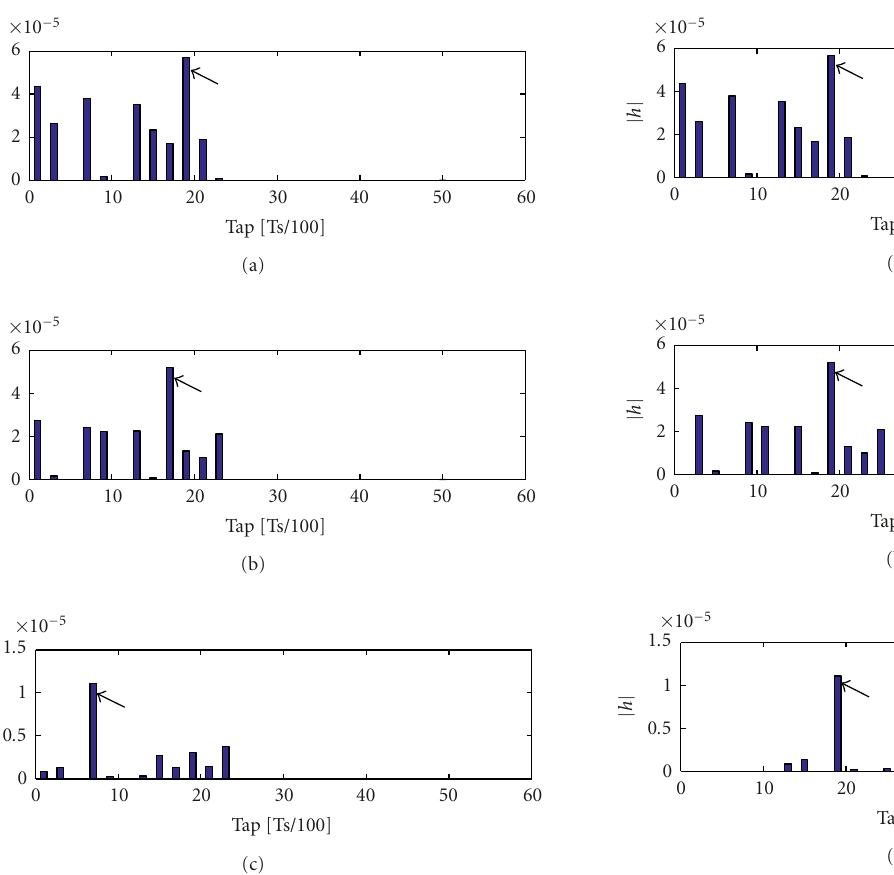
Figure 3: Impulse responses of the initial relay channel i , i = 1,2,3 in a typical urban environment.